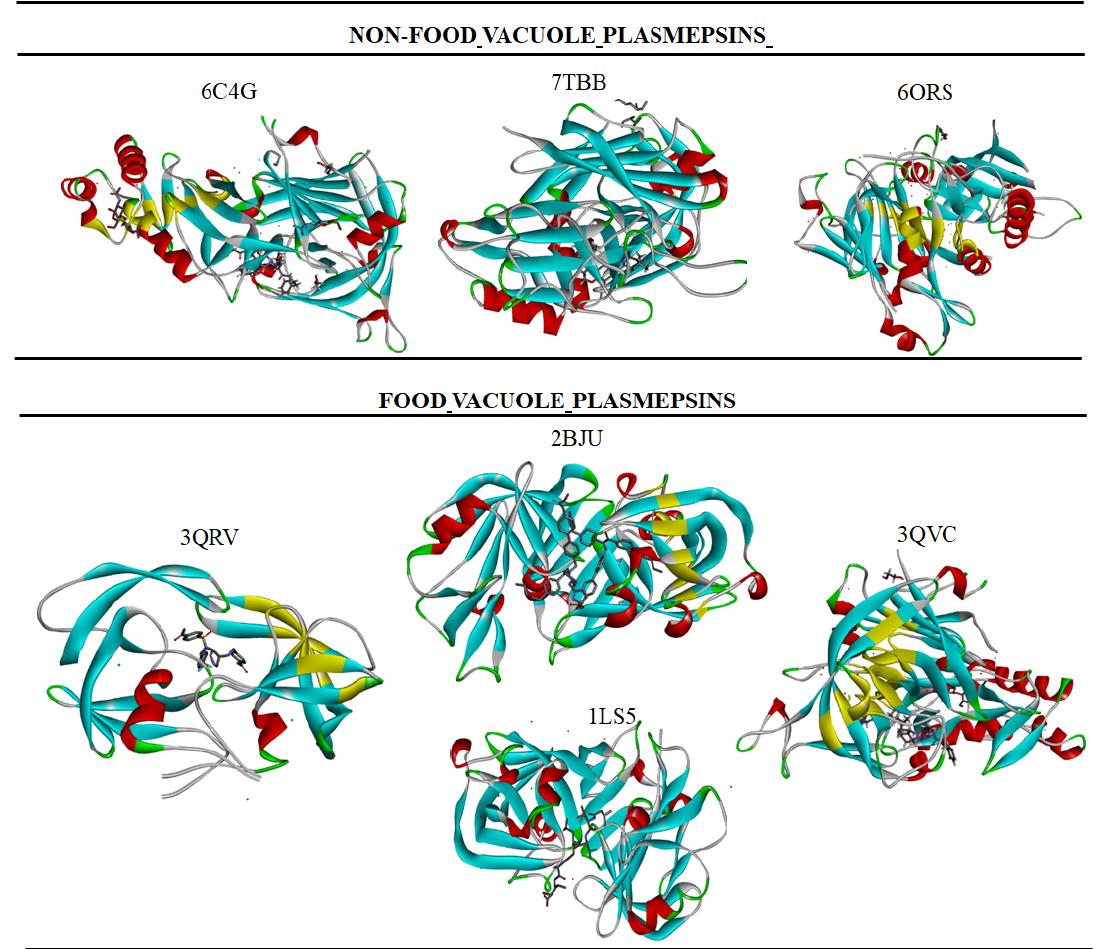
Figure 5. Crystallized structures and PDB code of complexes of P. falciparum and P. vivax Plasmepsins retrieved from the protein data bank (PDB) [35].